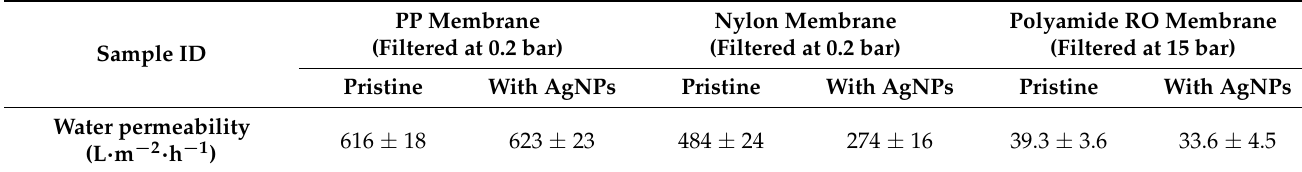
Table 5. Membrane Permeability for PP and Nylon Microfiltration, and Polyamide RO Membranes. PP Membrane Nylon Membrane Polyamide RO Membrane (Filtered at 0.2 bar) (Filtered at 0.2 bar) (Filtered at 15 bar) Sample ID Pristine With AgNPs Pristine With AgNPs Pristine With AgNPs Water permeability (L · m − 2 · h − 1